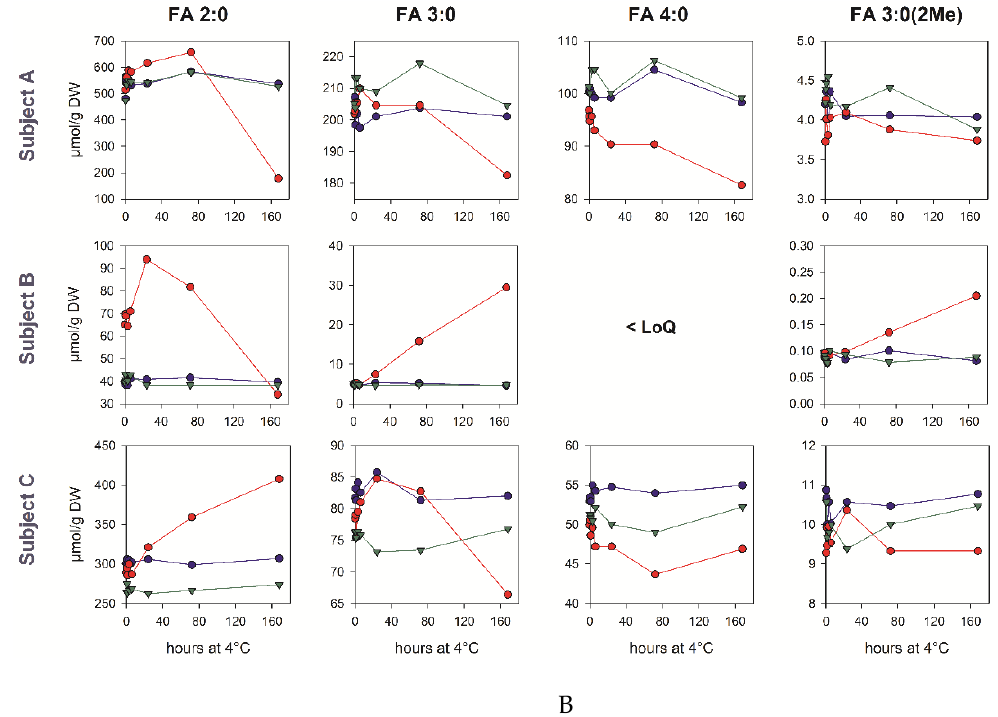
Figure 2. Pre-Analytic stability of SCFAs in human fecal samples. The homogenates of the fecal samples from three human donors, prepared either in water, 70% methanol, or 70% isopropanol, were kept for the indicated time at room temperature (panel A ) or at 4 °C (panel B ).